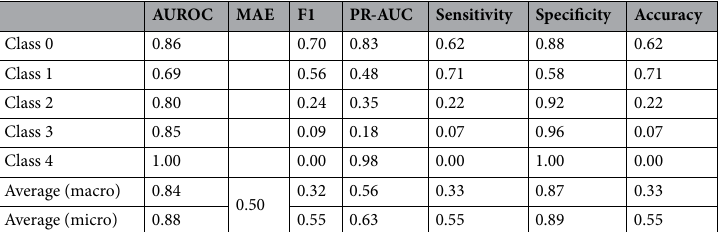
Table 1. Class-specific and average performance metrics for the nail-wise mNAPSI classifier. Macro average is performed by averaging the class-wise metrics with equal weight, while the micro average is performed by averaging the class-wise metrics with weights proportional to the number of samples from the specific class. Classes 0 to 3 represent the corresponding mNAPSI scores for a single nail. Class 4 is an aggregate of all higher mNAPSI scores.